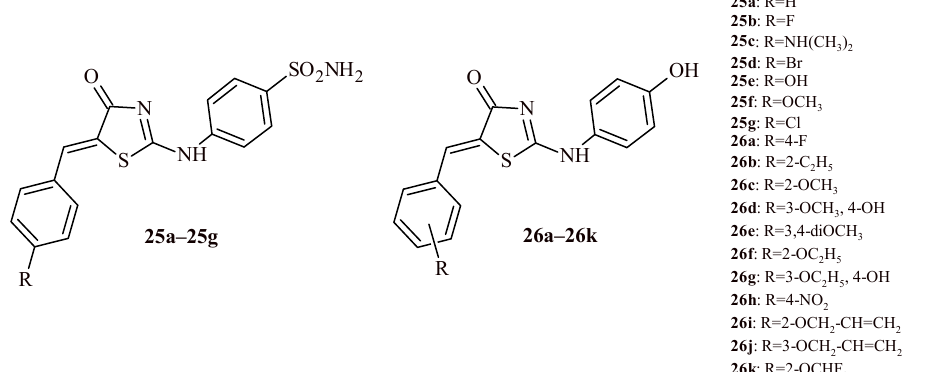
Figure 13. The structures of 5-arylidene-2-phenylaminothiazol-4( 5H )-one derivatives with antipro- liferative activity.